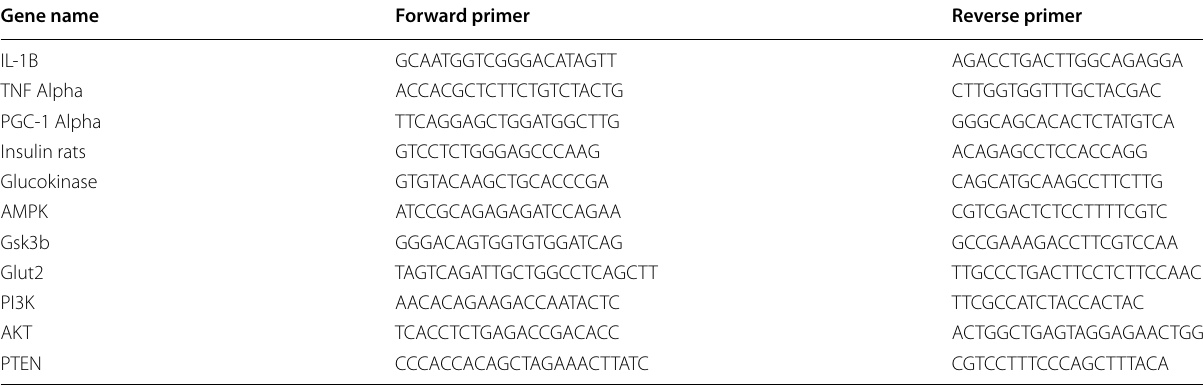
Table 1 List of designed, optimized and synthesized primers specific for each